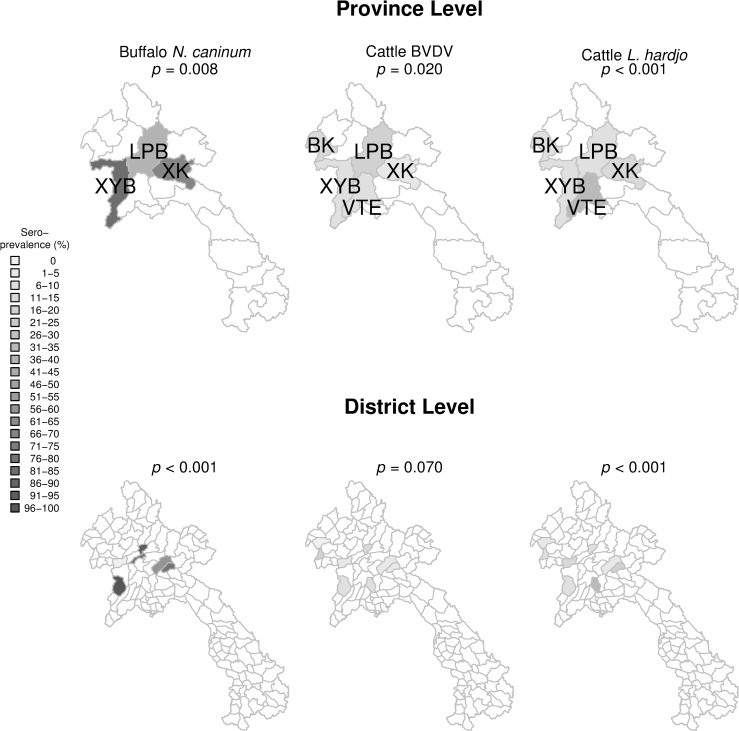
Spatial distribution heat map of buffalo Neospora caninum, cattle BVDV and cattle Leptospira interrogans serovar Hardjo (L. hardjo) antibodies in provinces in Lao PDR detected by enzyme-linked immunosorbent assay.Maps and Fisher exact tests to assess variation in sero-prevalence between provinces were generated using R statistical software.